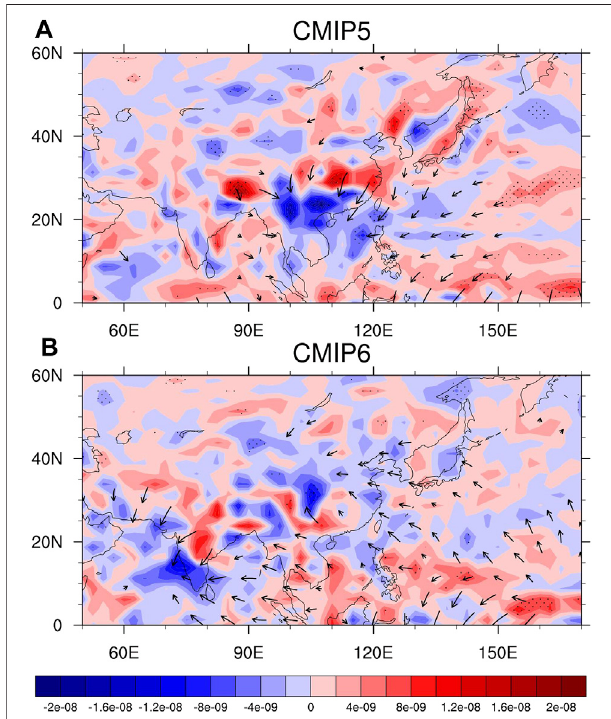
FIGURE 8 | The changes of the 850 hPa moisture fl ux divergence anomaly(shadings,g/(m 2 · s))andmoisturetransportanomaly(vectors)during strong EP events in the following summer for CMIP5 ( A . RCP8.5-historical) and CMIP6 ( B . SSP5-85-historical) MME results.